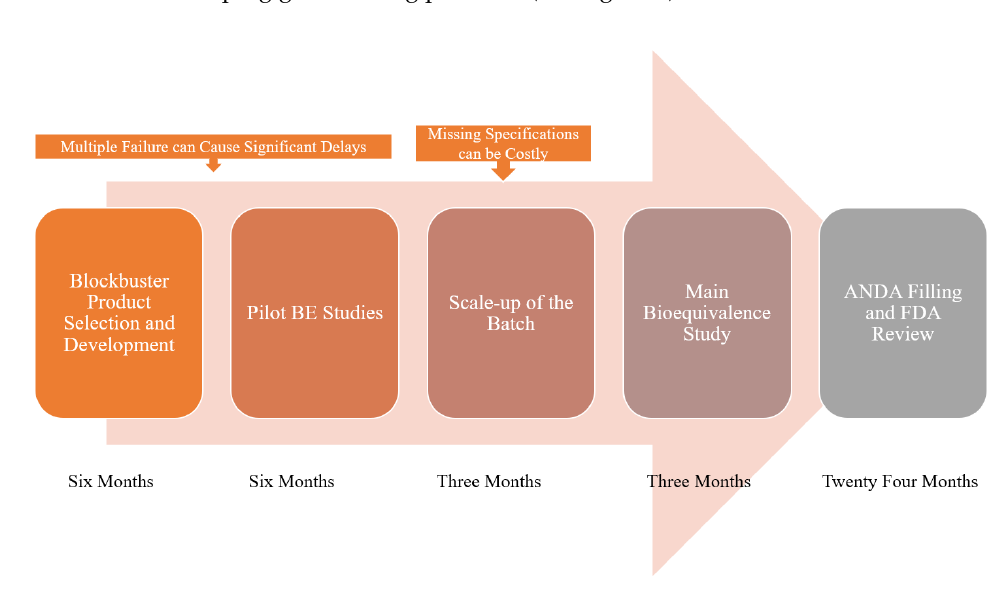
Figure 1. Scheme showing the development process of a generic product and where the delays can be circumvented using in silico platforms.